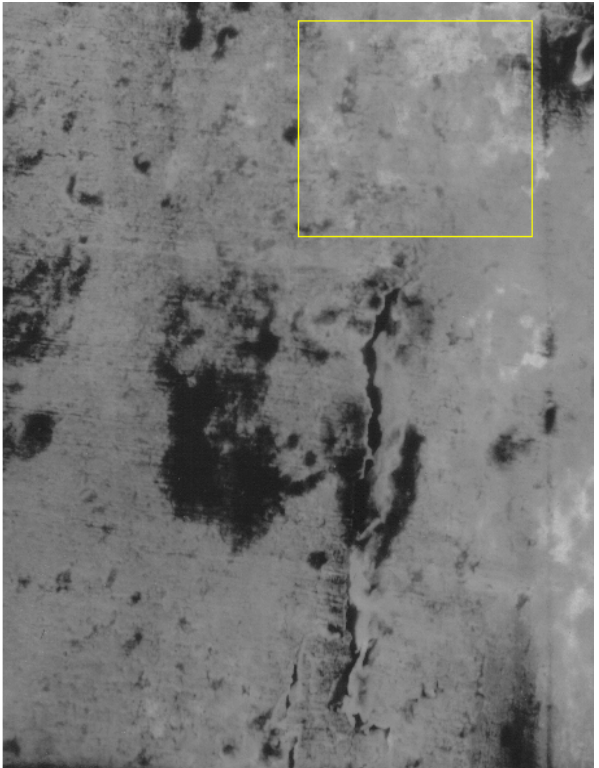
Figure 13. The selection of a normal area.